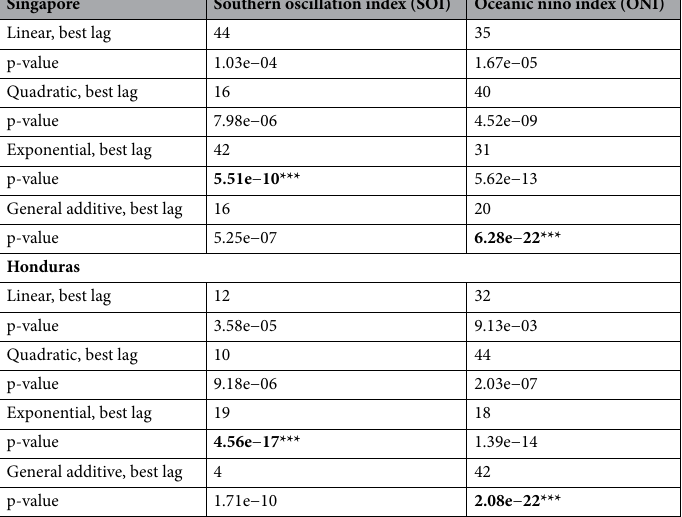
Table 5. El Niño Index correlation with reported case data in both countries. Significance values are in bold.